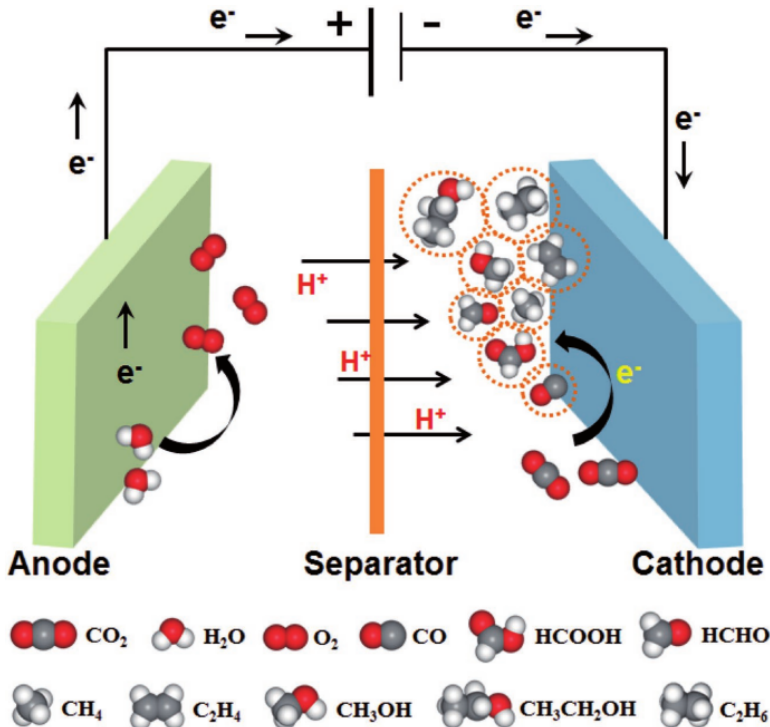
Figure 1. Schematic diagram of the electrochemical CO 2 reduction reaction system. Reproduced with permission from Ref. [16]. Copyright 2018, Wiley-VCH Verlag.